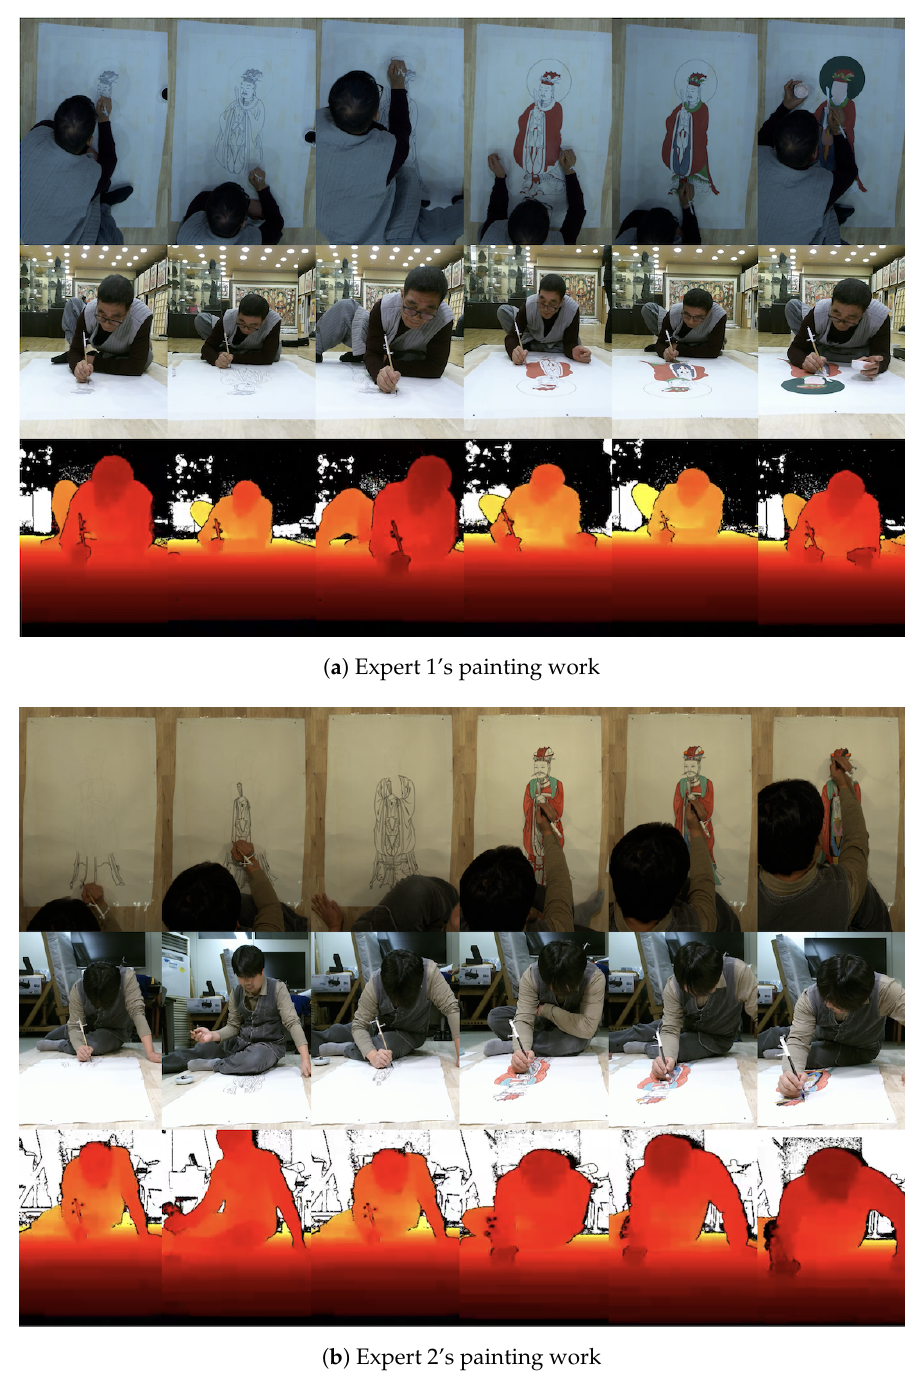
Figure 17. Two experts’ painting work. The top images are from the canvas cinema camera. The middle images are color ones from the Kinect. The bottom images are depth images from the